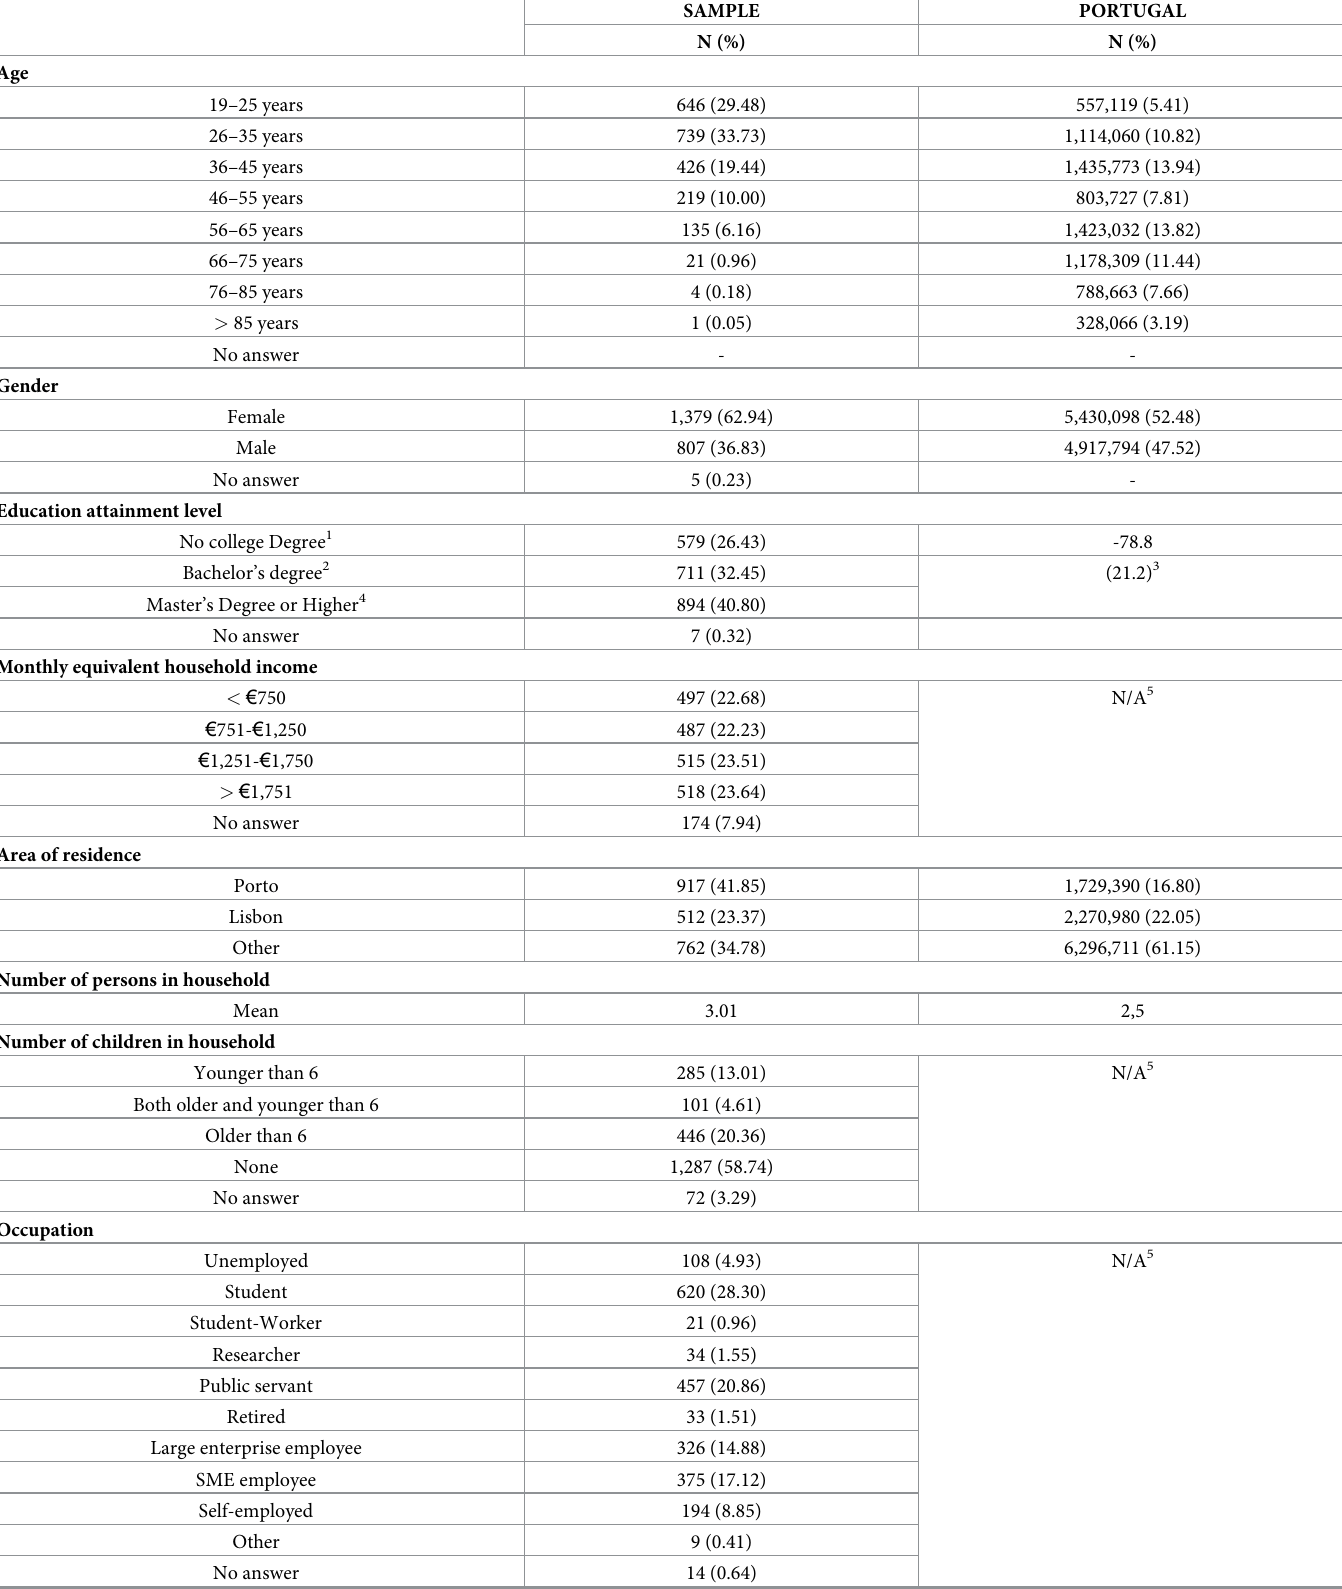
Table 3. Key descriptive statistics for the sample and comparison with the Portuguese population.